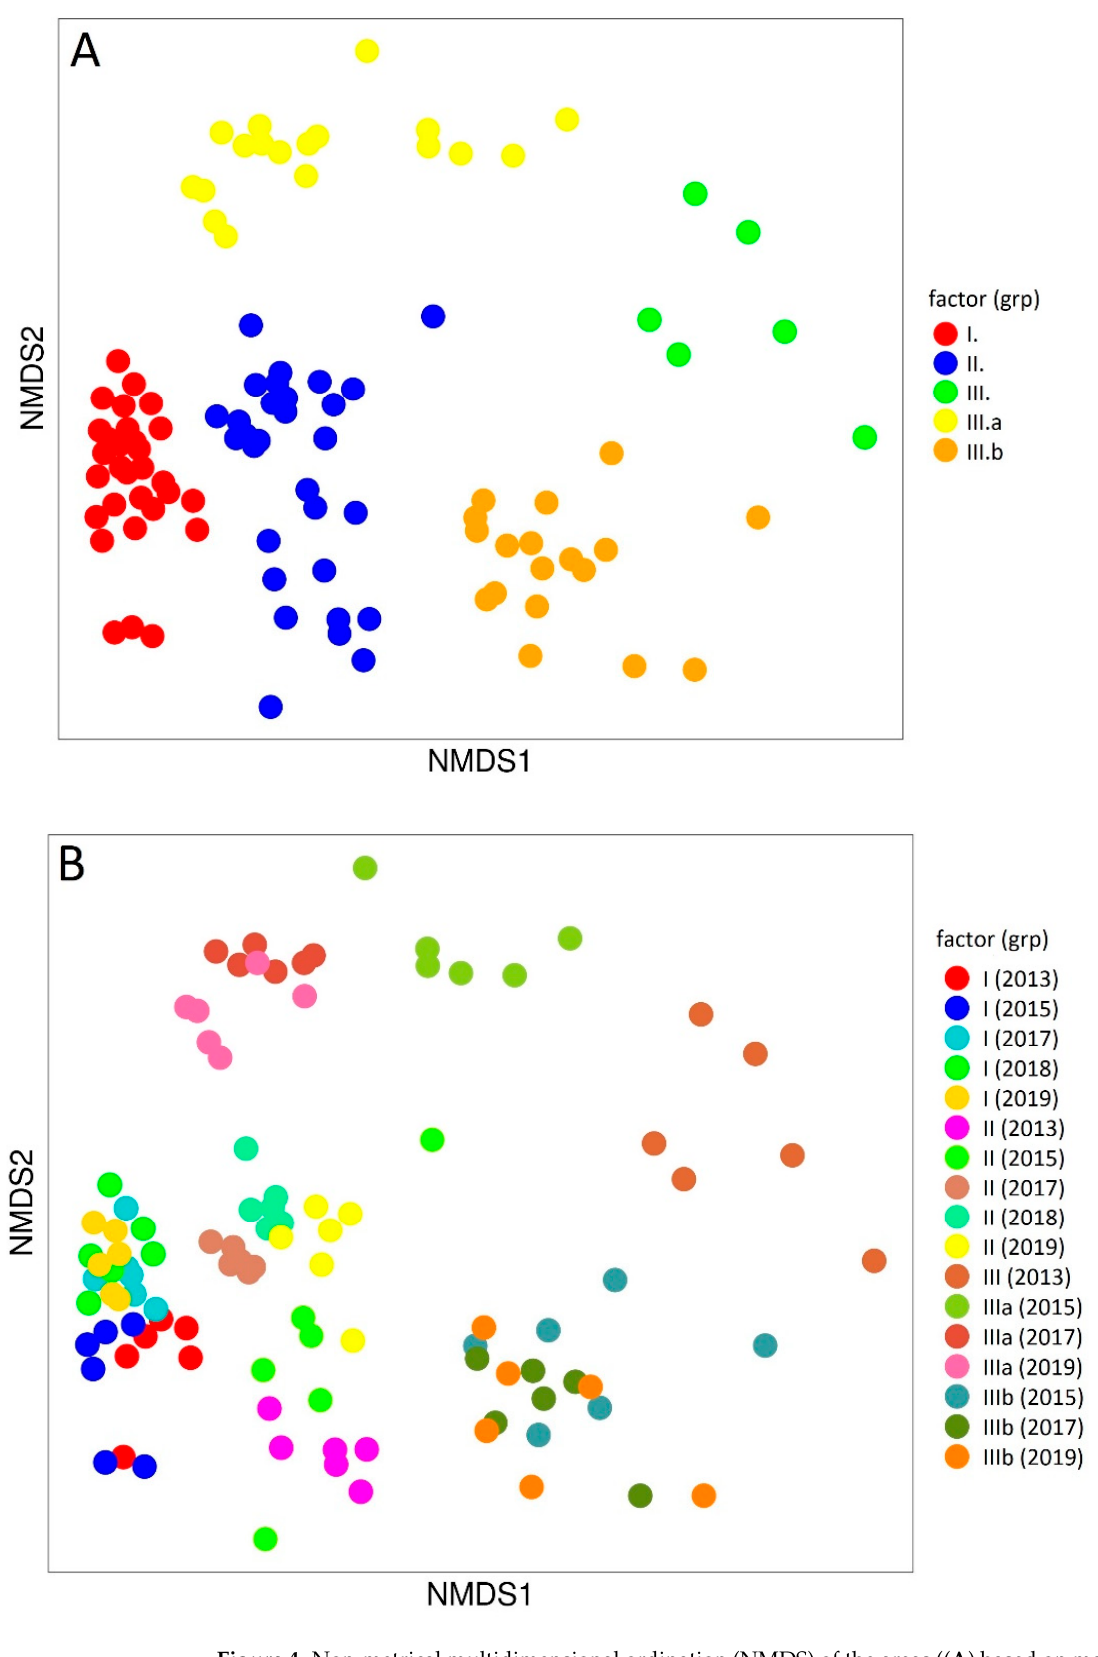
Figure 4. Non-metrical multidimensional ordination (NMDS) of the areas (( A ) based on management methods, ( B ) based on years); grp = group.